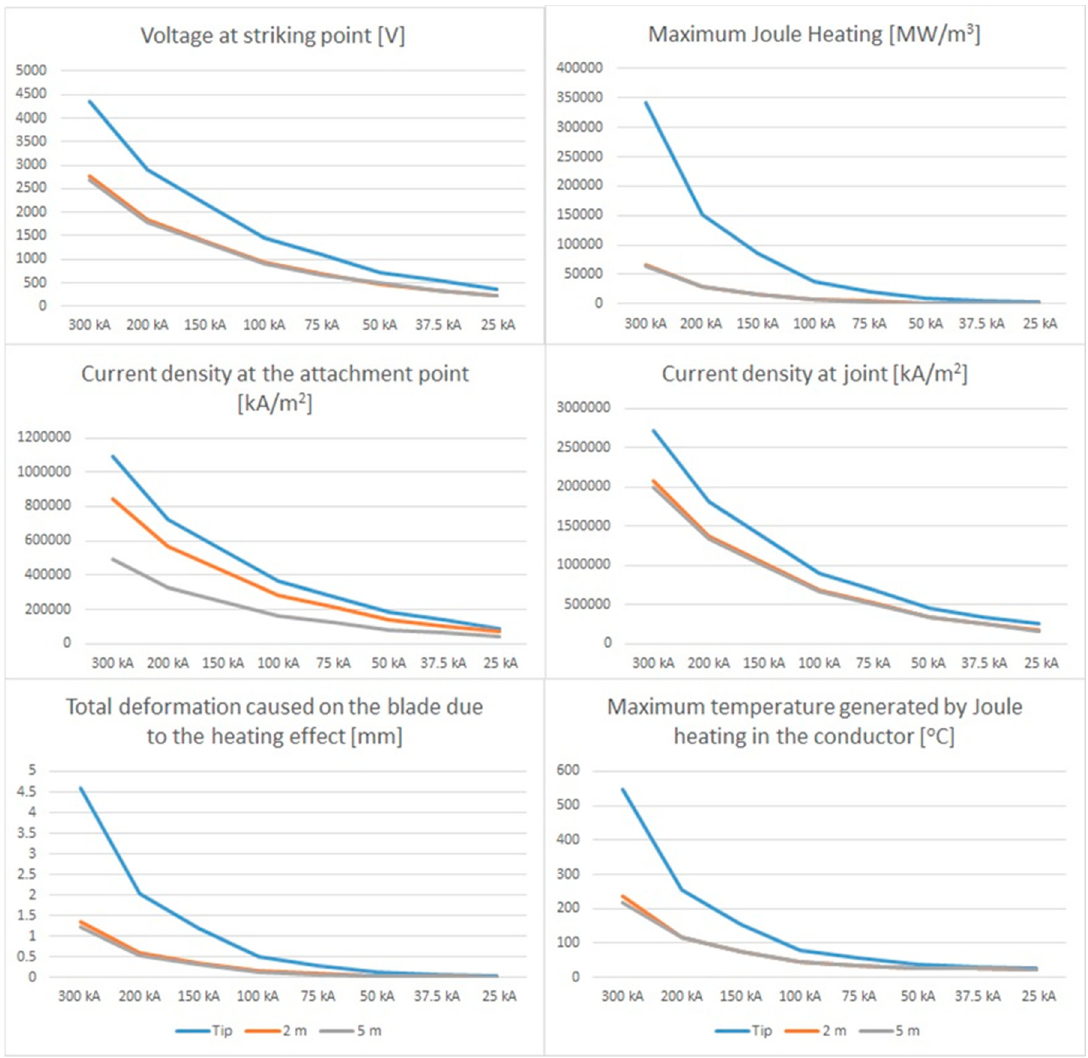
Figure A2. Plotted results from hybrid simulations.